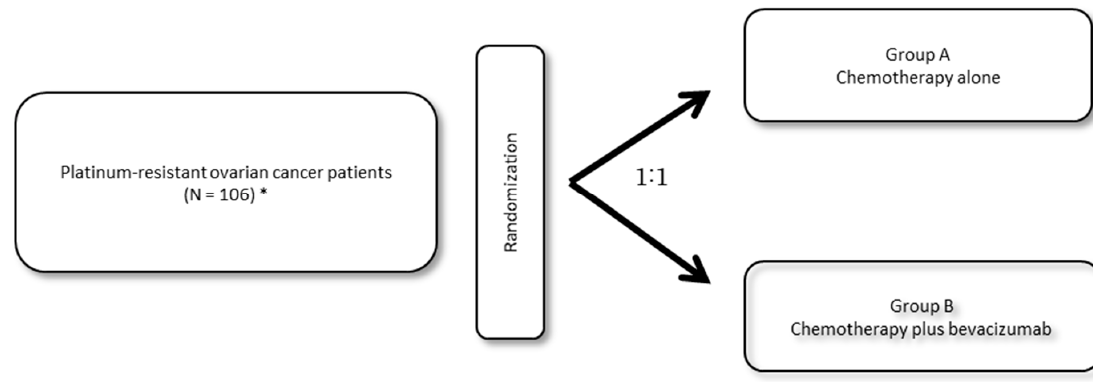
Figure 1. JGOG3023 Schema. Platinum-resistant ovarian cancer patients will be randomized 1:1 to treatment with chemotherapy alone or chemotherapy plus bevacizumab. *Defined as progression within < 6 months from completion of a minimum of three platinum therapy (including bevacizumab) cycles.